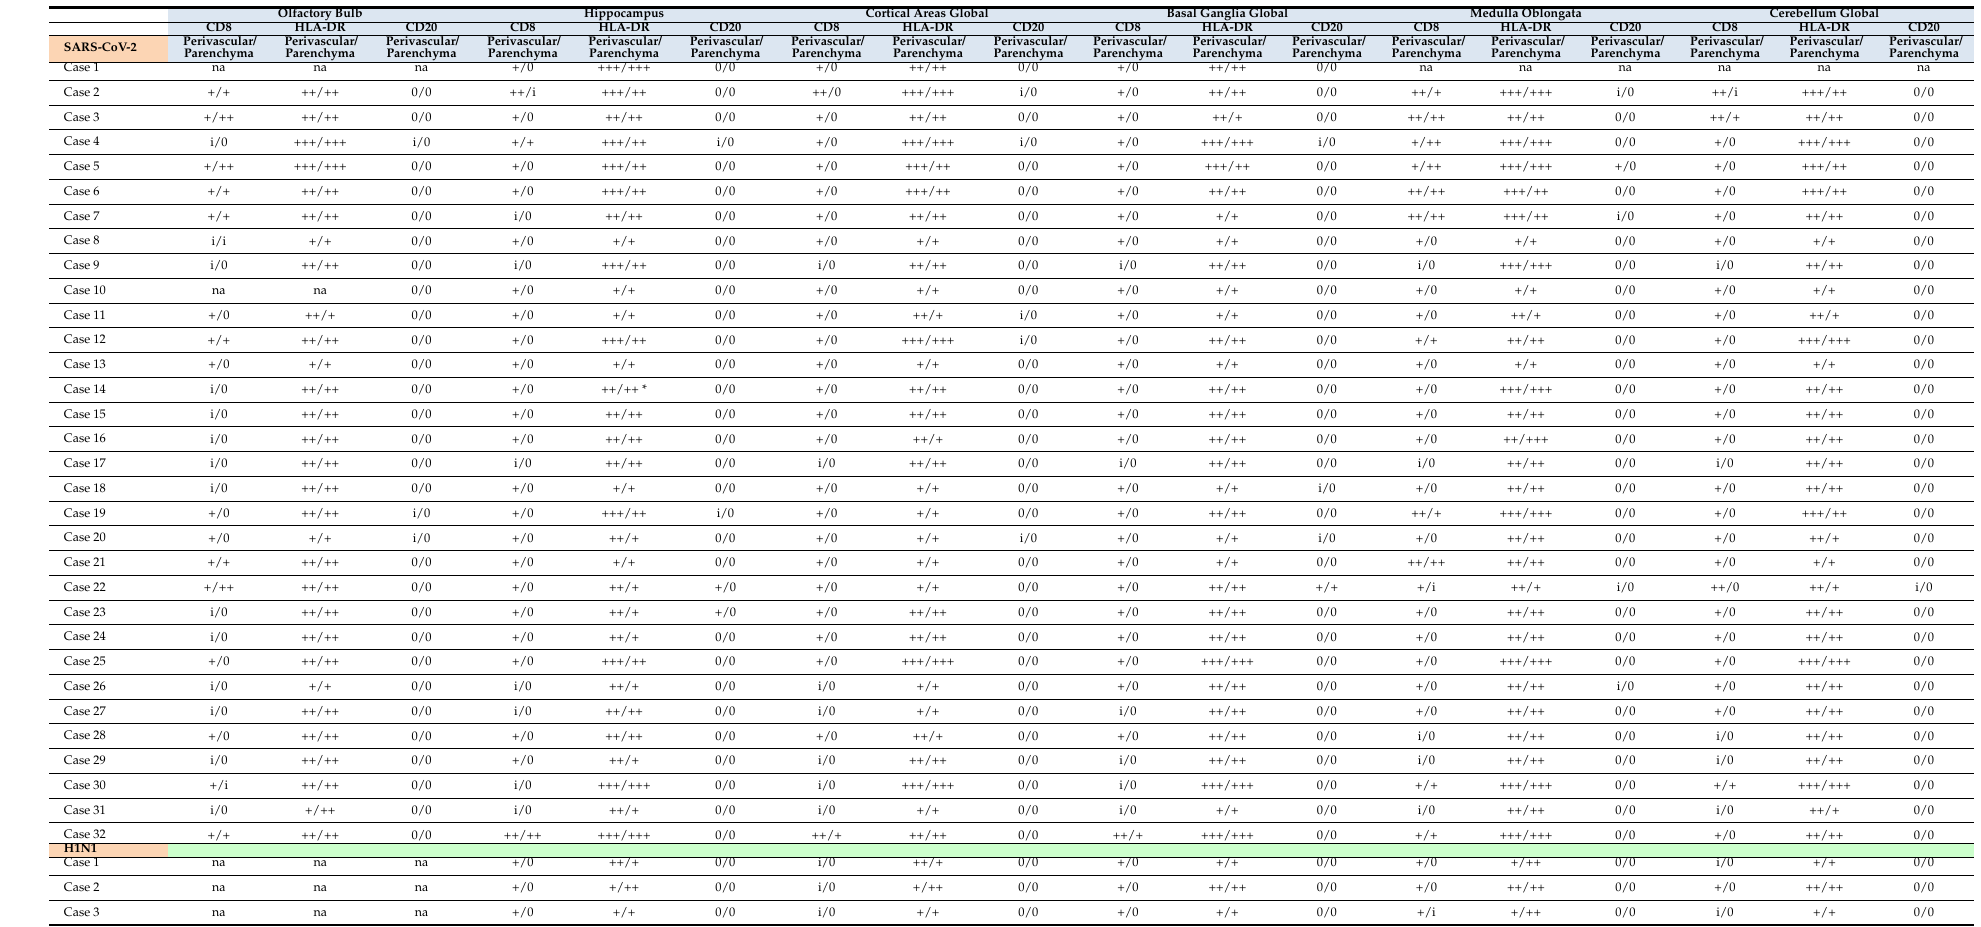
Table 2. Distribution of inflammatory infiltrates in selected brain areas in SARS-CoV-2 and H1N1 infection (0 = absent, i = isolated, + = mild, ++ = moderate, +++ abundant; for scoring details please see Section